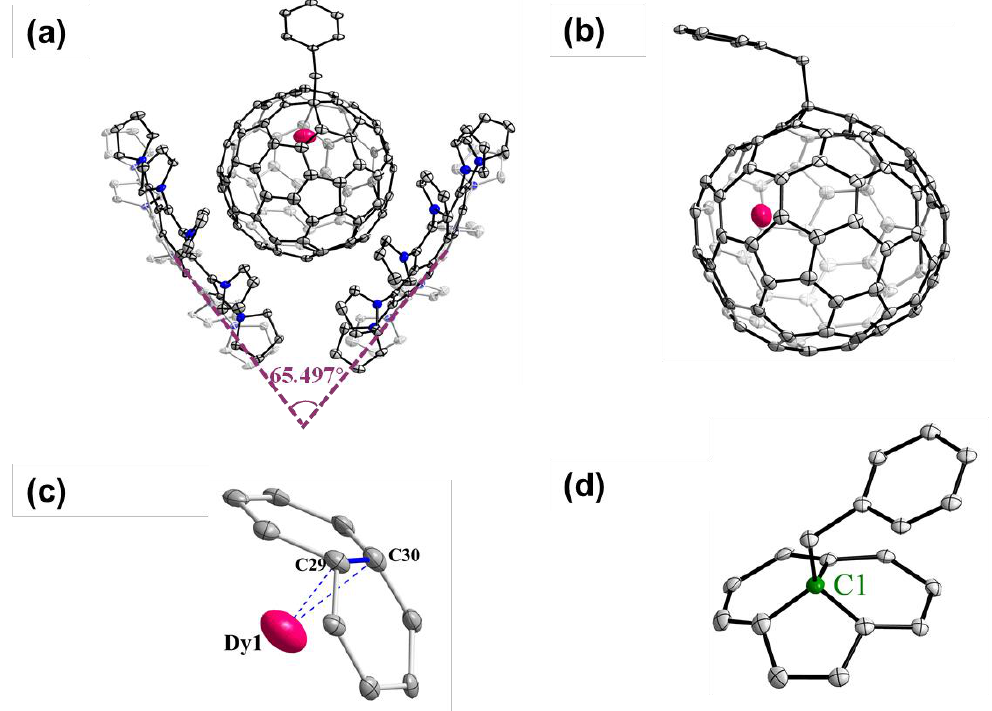
Figure 3. Drawing of ( a ) Dy@ C 2v (5)-C 80 (CH 2 Ph) · 2DPC and ( b ) Dy@ C 2v (5)-C 80 (CH 2 Ph). ( c ) Fragment view showing the interaction of the major Dy1 with the closest carbon atoms of the cage and ( d ) the addition site of benzyl. Only major Dy site is shown. Solvent molecules and H atoms are omitted for clarity. Gray: C; blue: N; fuchsia: Dy.